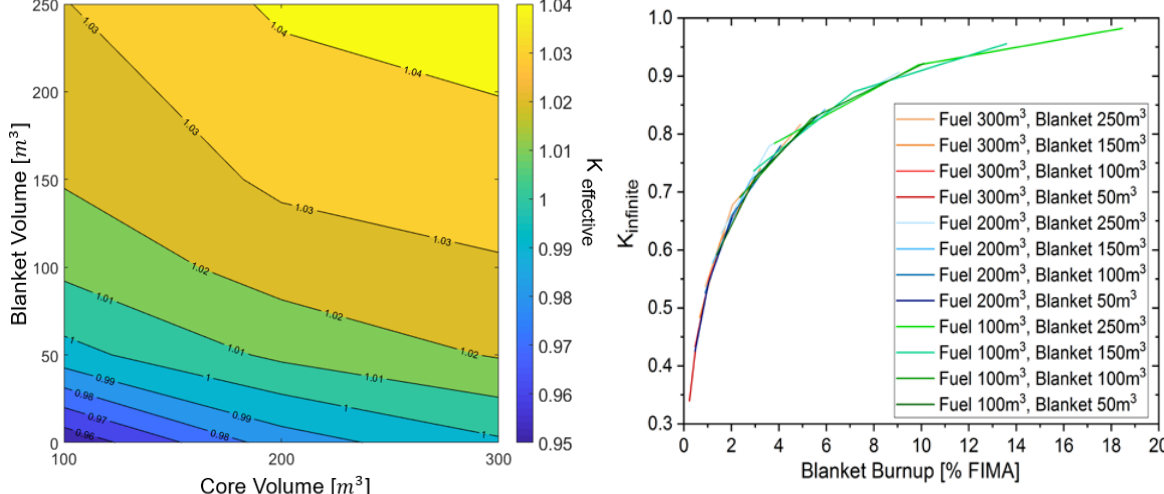
Figure 5. K effective and blanket K infinite . Dependence of k effective on the core and blanket volumes for 33% burnup on the left. Dependence of blanket k infinite on blanket burnup on the